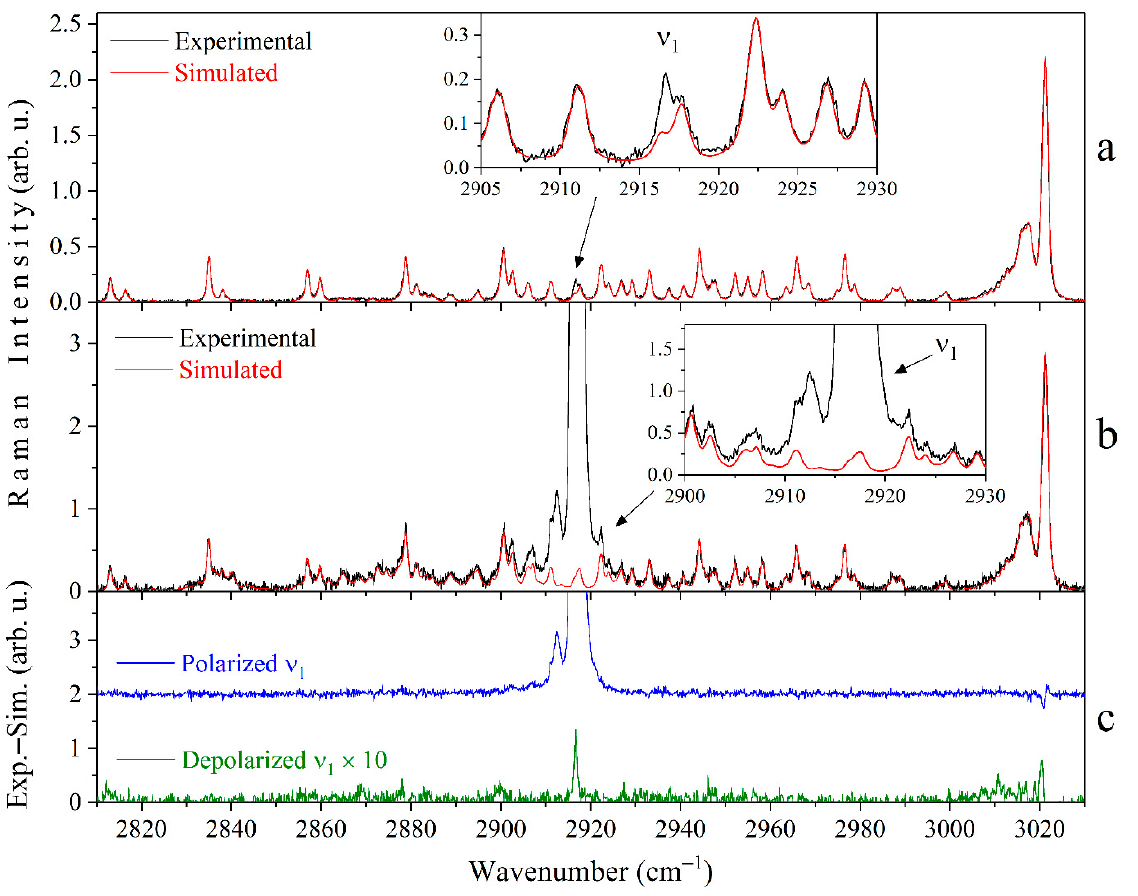
Figure 4. Subtraction procedure of the simulated spectra from the depolarized ( a ) and polarized ( b ) experimental Raman spectra of pure CH 4 at a pressure of 0.5 MPa. The spectra are normalized by the integrated intensity of the Q branch of the ν 3 band. Panel ( c ) shows the obtained differences, where the depolarized spectrum is magnified 10 times for visualization.